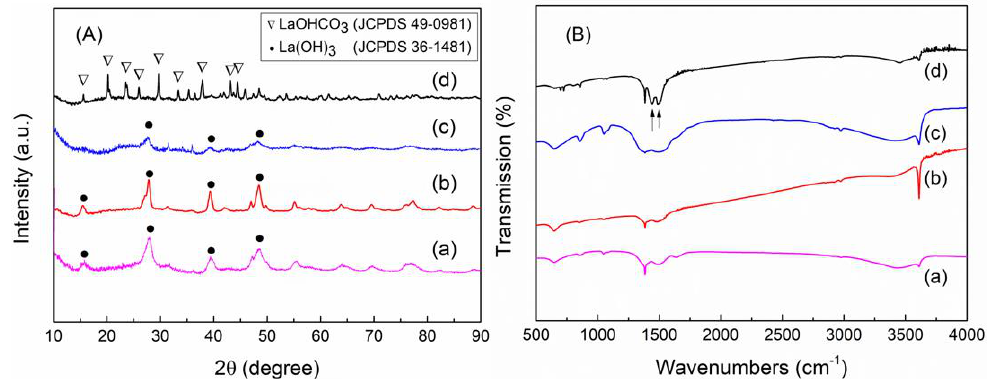
Figure 4. ( A ) XRD patterns and ( B ) FT-IR spectra of uncalcined samples. ( a ) HL-6h, ( b ) HL-12h, ( c ) PL-6h, and ( d )